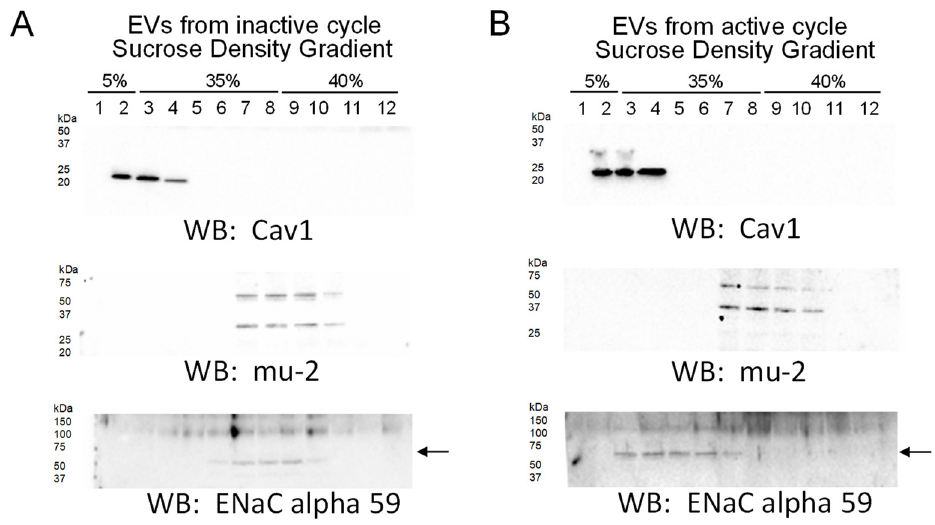
Figure 8. Sucrose density gradients showing the distribution of ENaC alpha subunit to lipid rafts after treating mpkCCD cells with uEVs from the active phase compared to the inactive phase. mpkCCD cells were challenged with uEVs from the inactive phase ( A ) or the active phase ( B ) before isolating lipid rafts and non-lipid rafts. Representative Western blots for ENaC alpha subunit protein expression in each fraction. Caveolin 1 (Cav1) is present in the light density gradient fractions corresponding to lipid rafts, while the mu-2 protein is present in non-lipid raft associated fractions. n = 2 independent experiments.